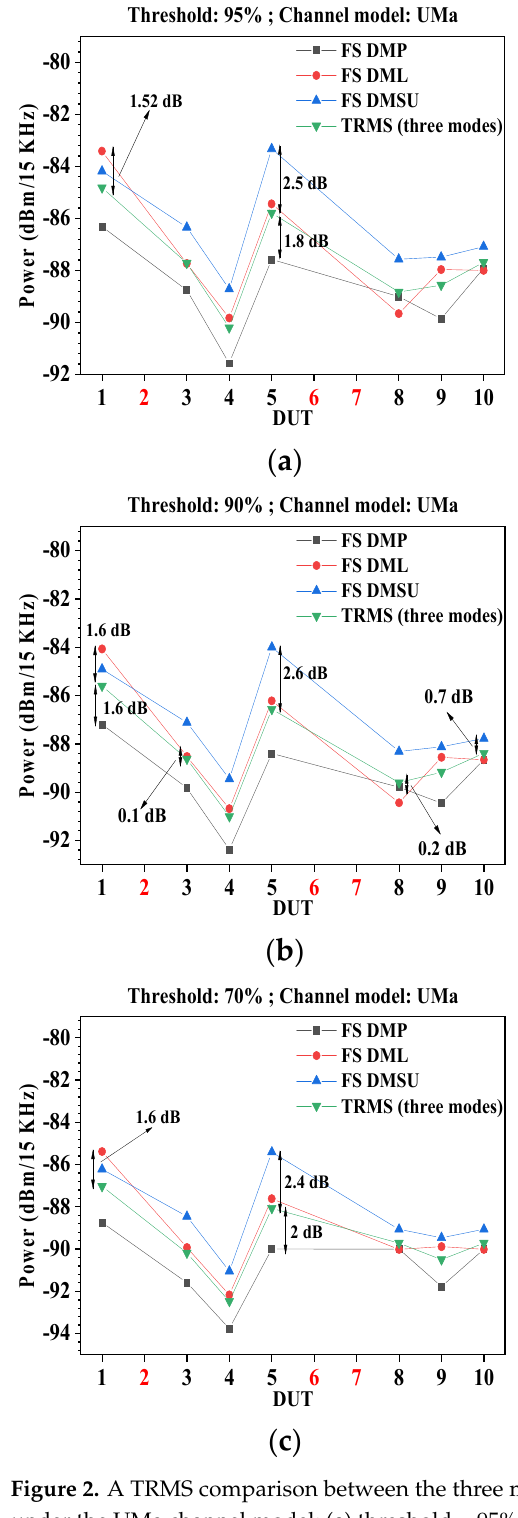
Figure 2. A TRMS comparison between the three modes and the averaged TRMS at all thresholds under the UMa channel model; ( a ) threshold = 95%, ( b ) threshold = 90%, ( c ) threshold = 70%.